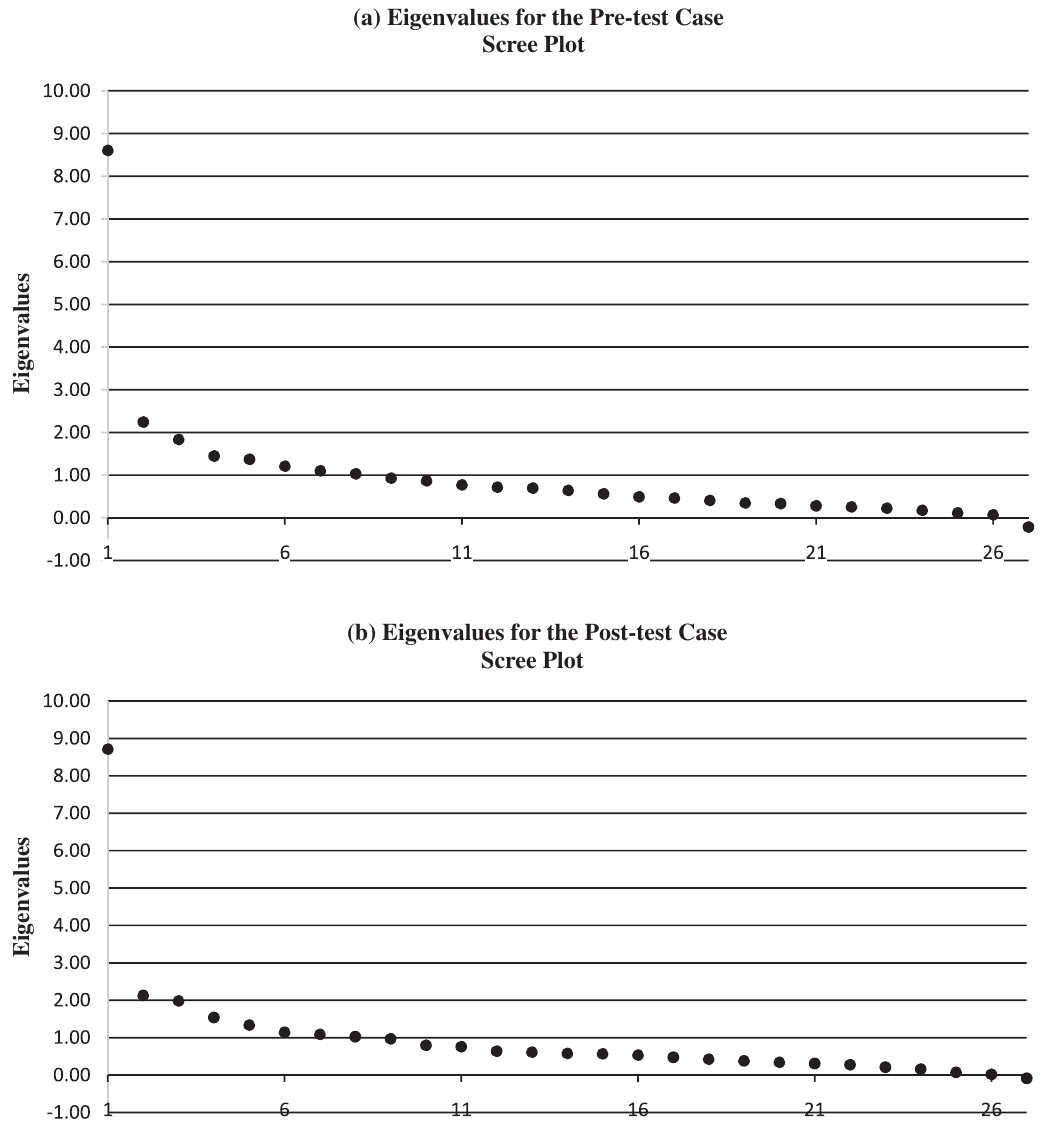
FIG. 1. The scree plots shown for the (a) pretest and (b) post-test